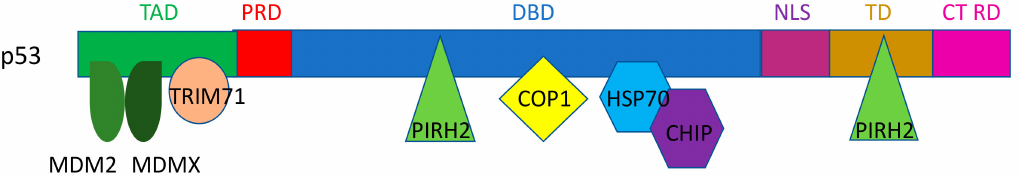
Figure 1. Schematic representation of interaction of p53 with di ff erent E3 ligases. Legend: TAD, transactivation domain; PRD, proline rich domain; DBD, DNA binding domain; NLS, nuclear localization signal; TD, tetramerization domain; CT RD, C terminal regulatory